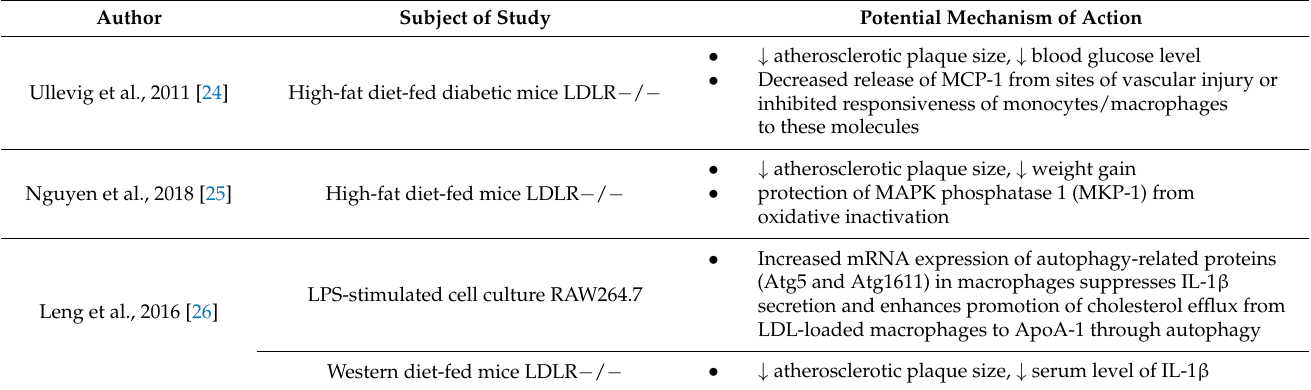
Table 1. Ursolic acid—effects and proposed mechanisms of its activity in managing